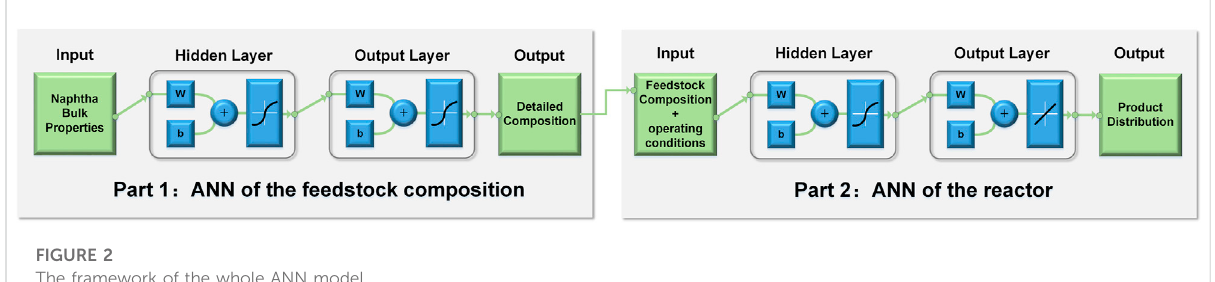
FIGURE 2 The framework of the whole ANN